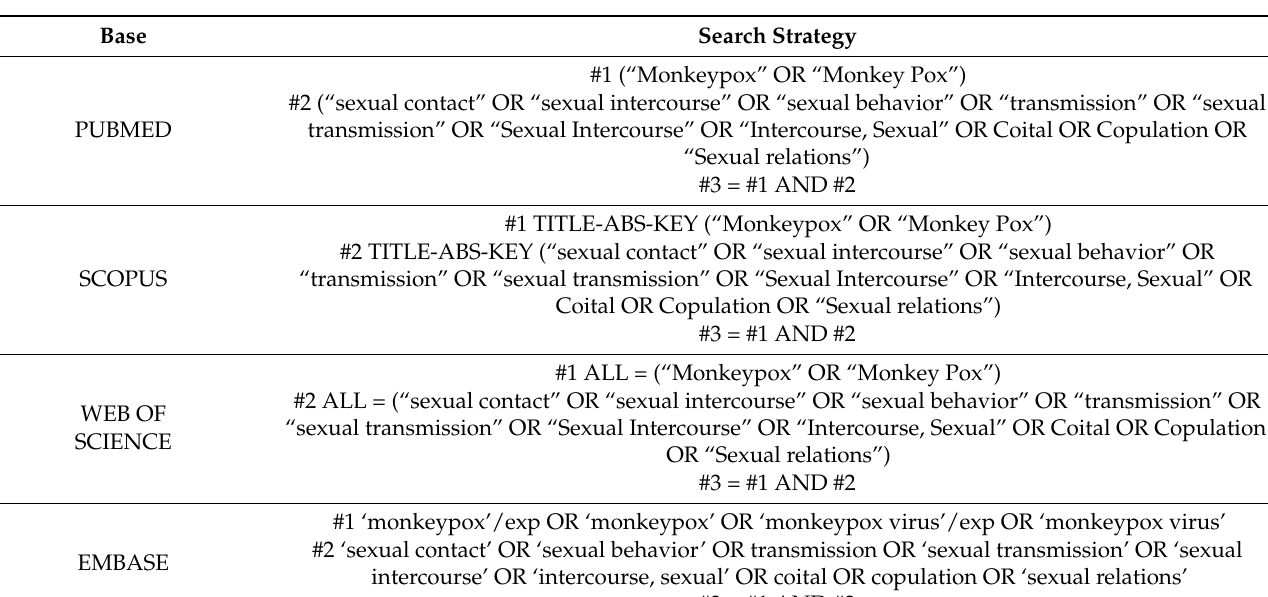
Table 1. Bibliographic search